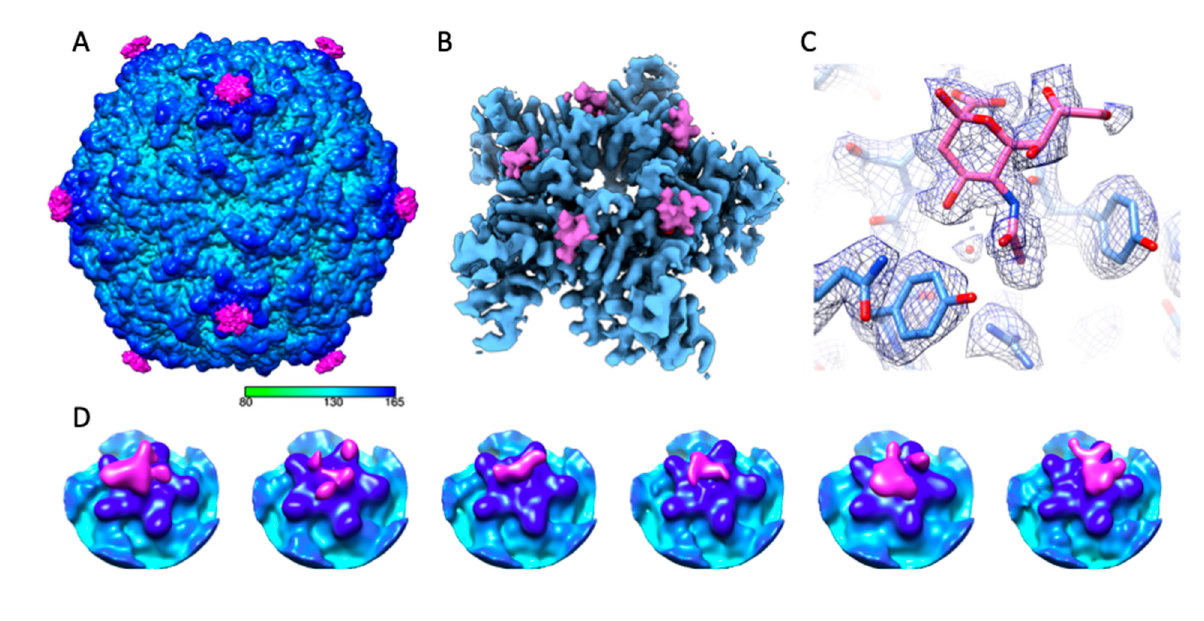
Figure 4. Cryo-EM analysis of CVA24v in complex with compound 14 . ( A ) Unsharpened cryo-EM reconstruction of CVA24v in complex with compound 14 , viewed down the icosahedral two-fold axis. The capsid is colored according to the radial coloring scheme, shown in angstroms, and the density corresponding to compound 14 , visible at the five-fold symmetry axis, is colored magenta. ( B ) Enlarged view of a single capsid five-fold from the sharpened cryo-EM map, showing clear density for the sialic acid component of compound 14 . ( C ) Zoomed in view of a single sialic acid binding site shown in ( B ). ( D ) 3D classes obtained from no-alignments, focused classification of the five-fold symmetry axis, colored as in ( A ).